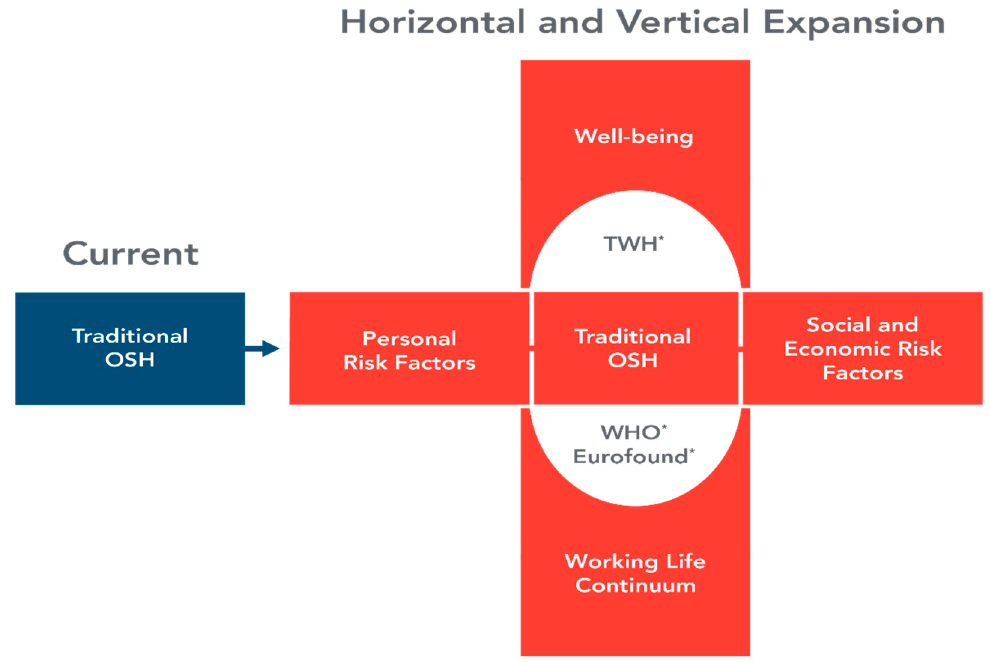
Figure 1. An expanded focus for occupational safety and health. * Horizontal and vertical expansion build on the work of WHO [20], Eurofound [21], and TWH [22,23].